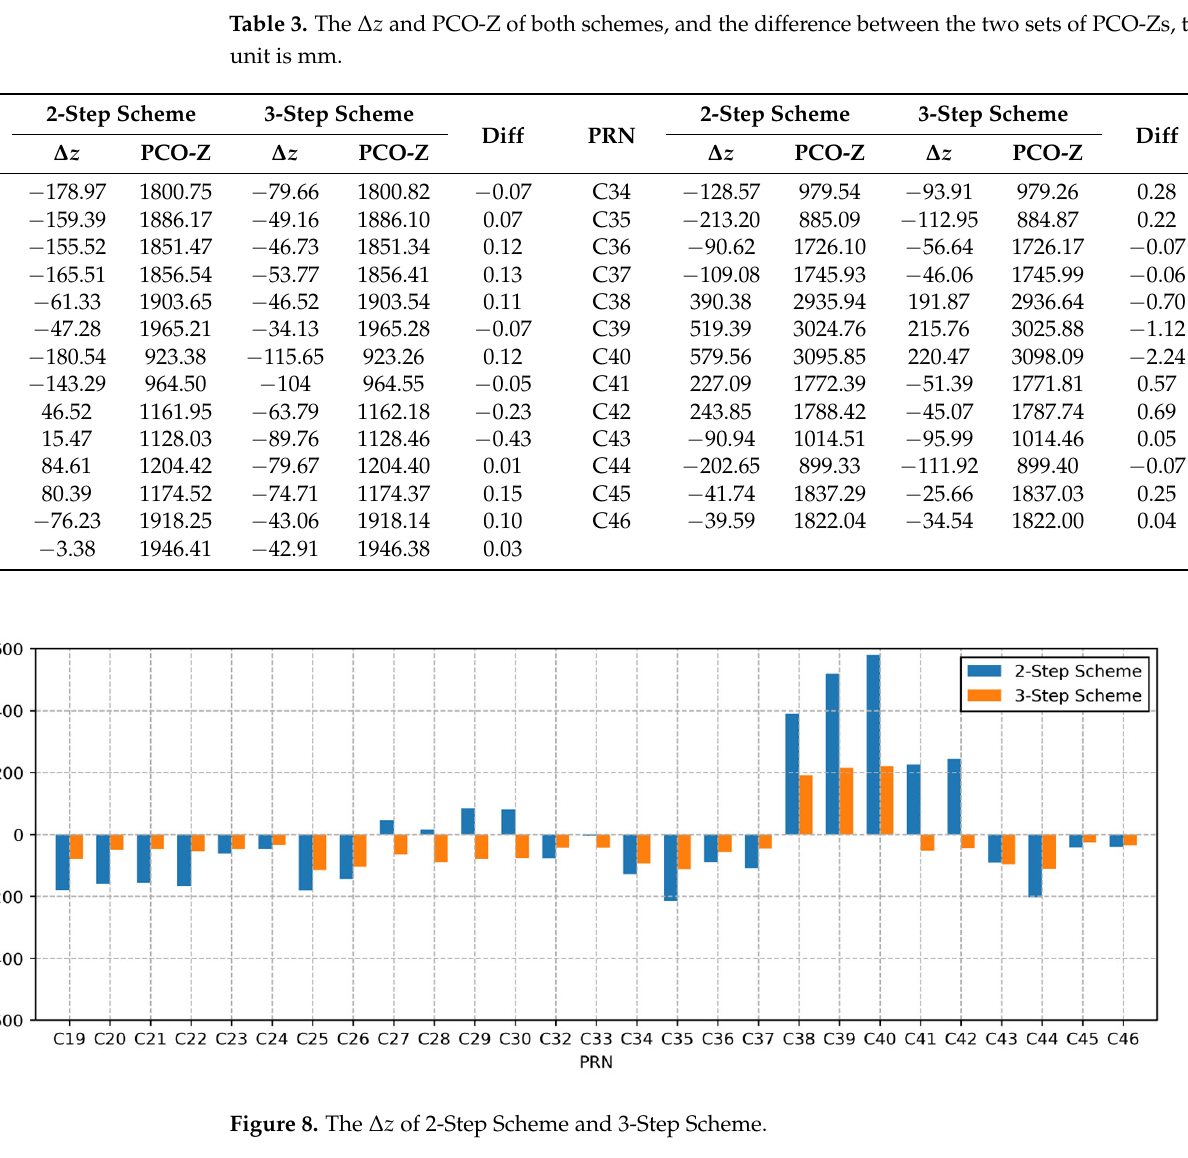
Figure 8. The Δ of 2-Step Scheme and 3-Step Scheme. Figure 8. The ∆ z of 2-Step Scheme and 3-Step Scheme. Table 4 is the PCV of the 3-Step Scheme, and Table 5 is the PCV of the 2-Step Scheme. The two sets of PCVs have nearly no difference. The maximum absolute difference is 0.12 mm and only appears at the 0 ◦ nadir-angle of C42, the other absolute difference